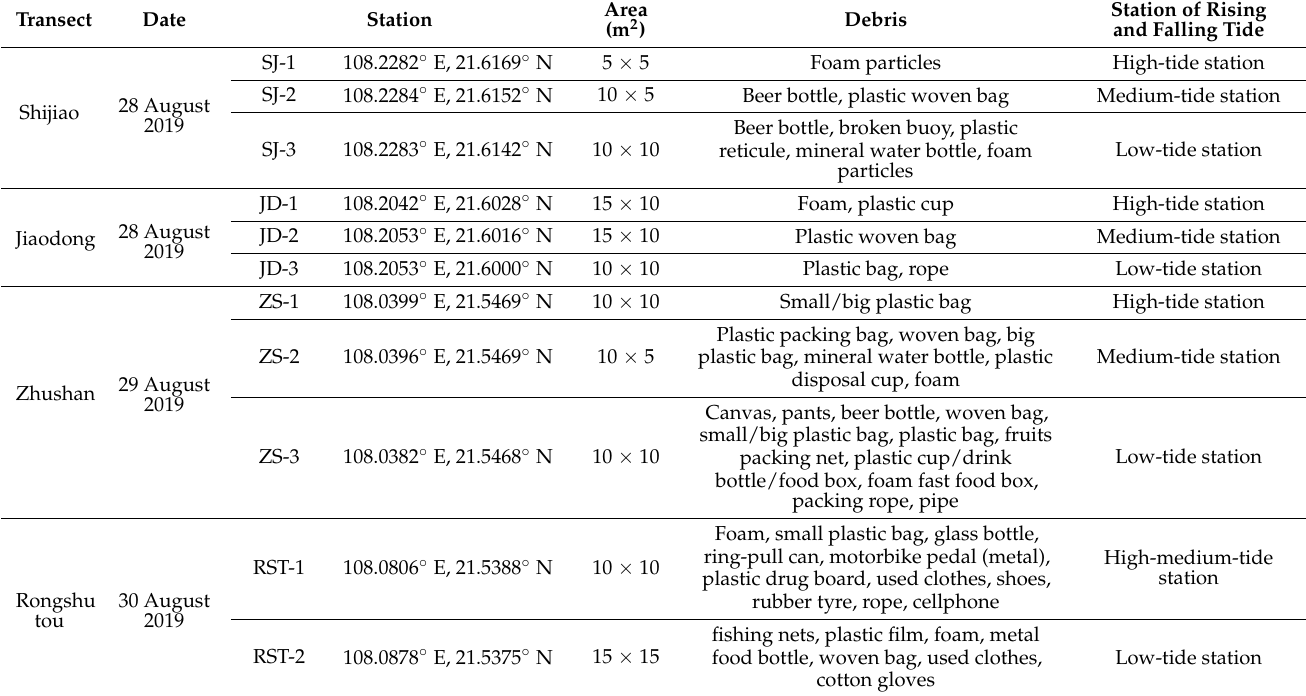
Table 2. The debris monitoring stations in Beilun Estuary mangrove forest